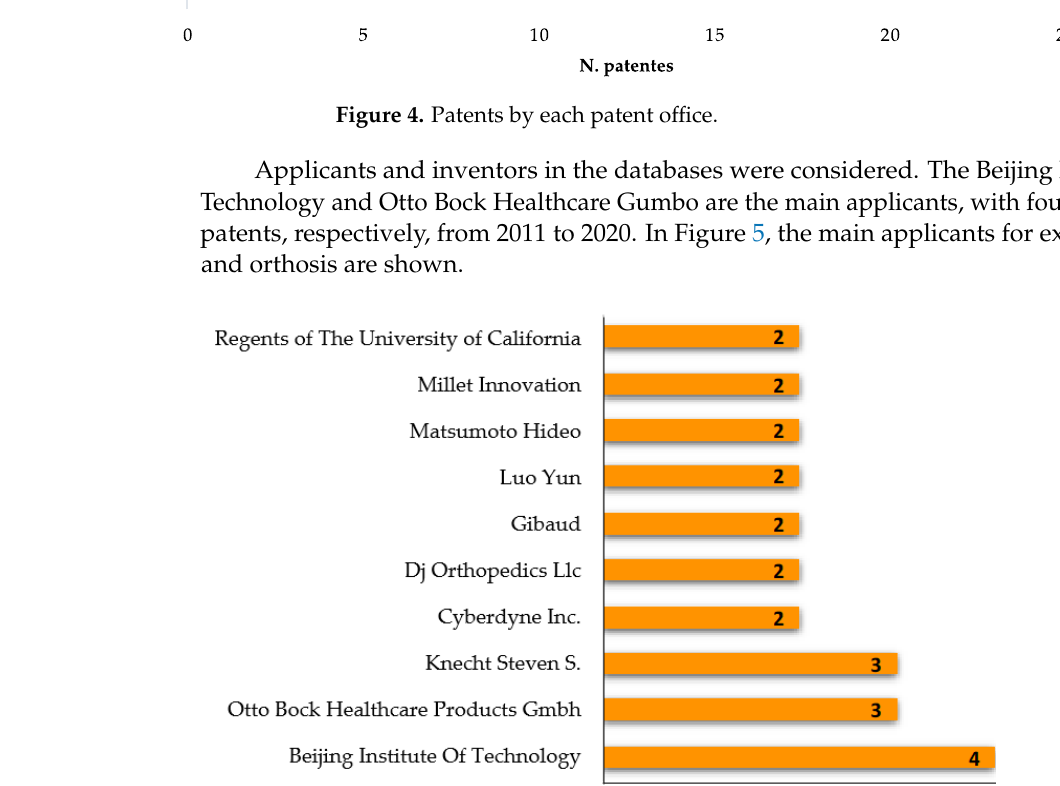
Figure 6. Documents by lower limb joint. Among the 74 results obtained, 29 results match with orthoses, 16 with braces, 14 with exoskeletons, 7 with devices, 2 with mechanisms, and 1 with exo-suit and prostheses. In addition, three results are associated with methodologies (manufacturing methods, de- sign methods, tests). Figure 7 shows the resulting patents and the distribution with the part of the body of the lower limb that they cover.